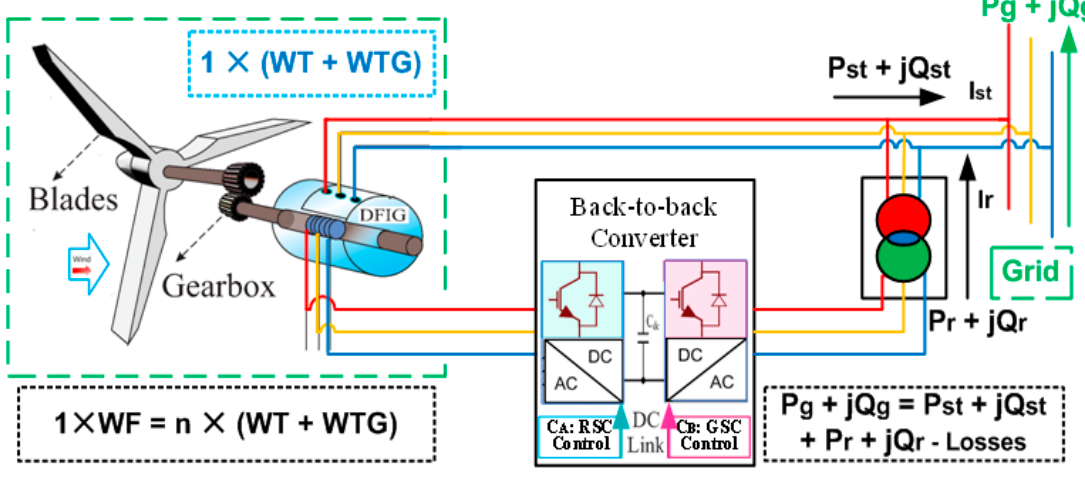
Figure A1. DFIG-based WT configuration in LSWF.